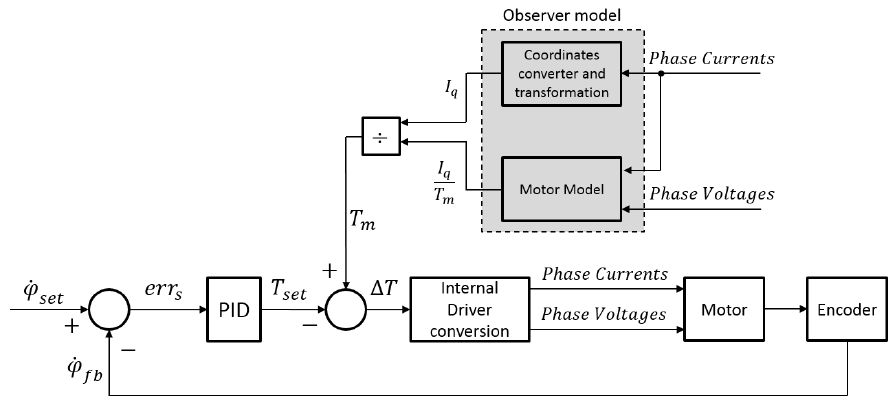
Figure 11. Block scheme of the control logic for the tests at constant rotational